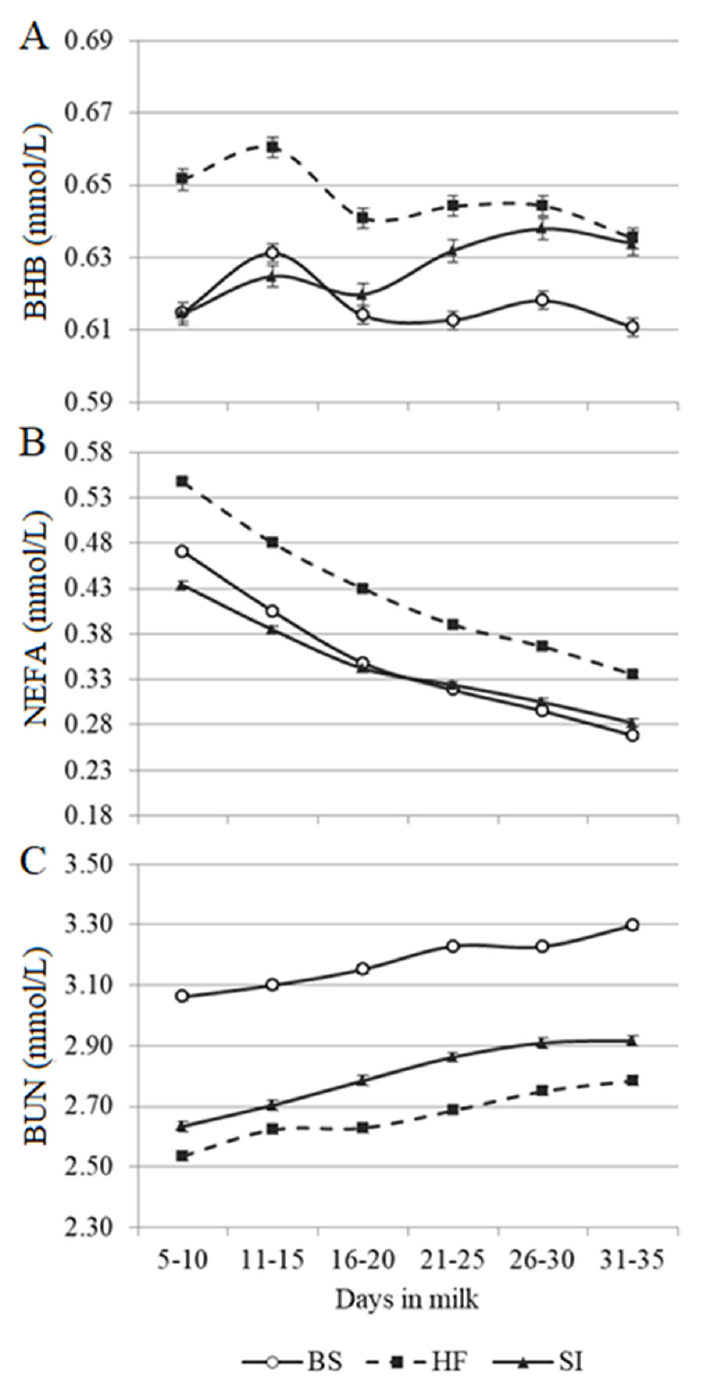
Figure 2. Least squares means of predicted ( A ) blood β -hydroxybutyrate (BHB), ( B ) blood non-esterified fatty acids (NEFA), and ( C ) blood urea nitrogen (BUN) in the first month of lactation of Brown Swiss (BS), Holstein-Friesian (HF), and Simmental (SI) cows in multi-breed herds. Log 10 -transformed BHB was the trait analyzed as dependent variable in the mixed model; however, for clarity of presentation, least squares means were back-transformed to present results in mmol / L. Vertical bars indicate the standard error.